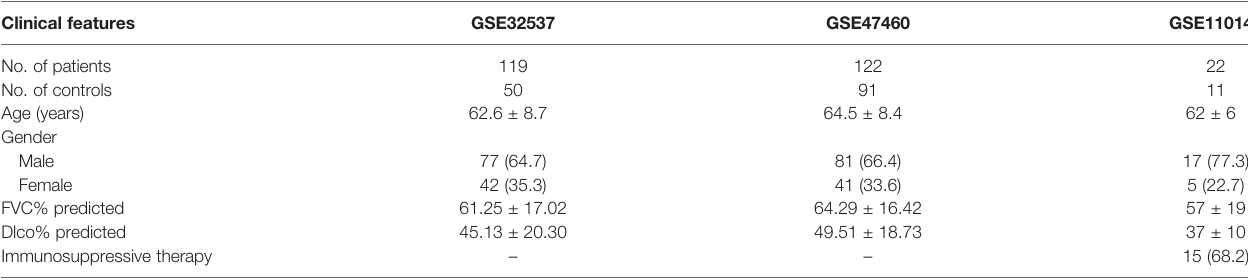
TABLE 2 | The clinical features of patients with IPF (lung tissue).